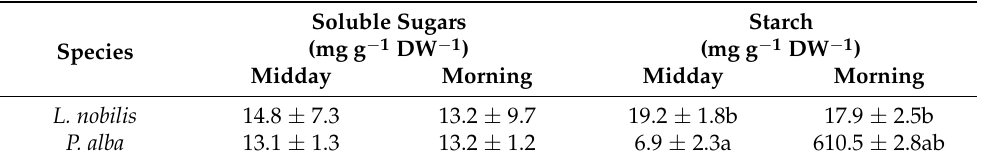
Table 5. Mean values ± SEM of soluble NSCs and starch content as recorded in well-watered samples of L. nobilis and P. alba at midday and on the following morning on the same days of hydraulic measurements in water-stressed samples. Different letters indicate statistically significant differences based on two-way ANOVA.